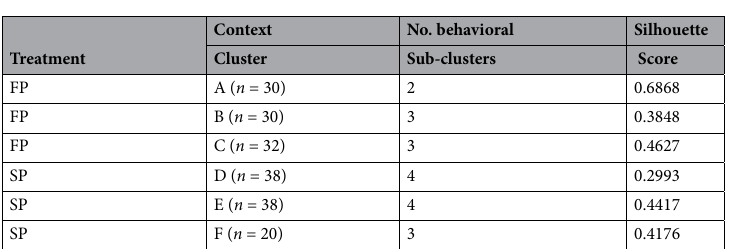
Table 2. Summary of the clustering results using K-Means. The contextual clustering results in 3 clusters of similar sizes. The behavioral clustering per context yielded 8 behavioral sub-clusters in FP and 11 behavioral sub-clusters in SP. The scikit-learn 53 silhouette analysis was used to determine the quality of the clusters generated with the “elbow” method (see “Methods”